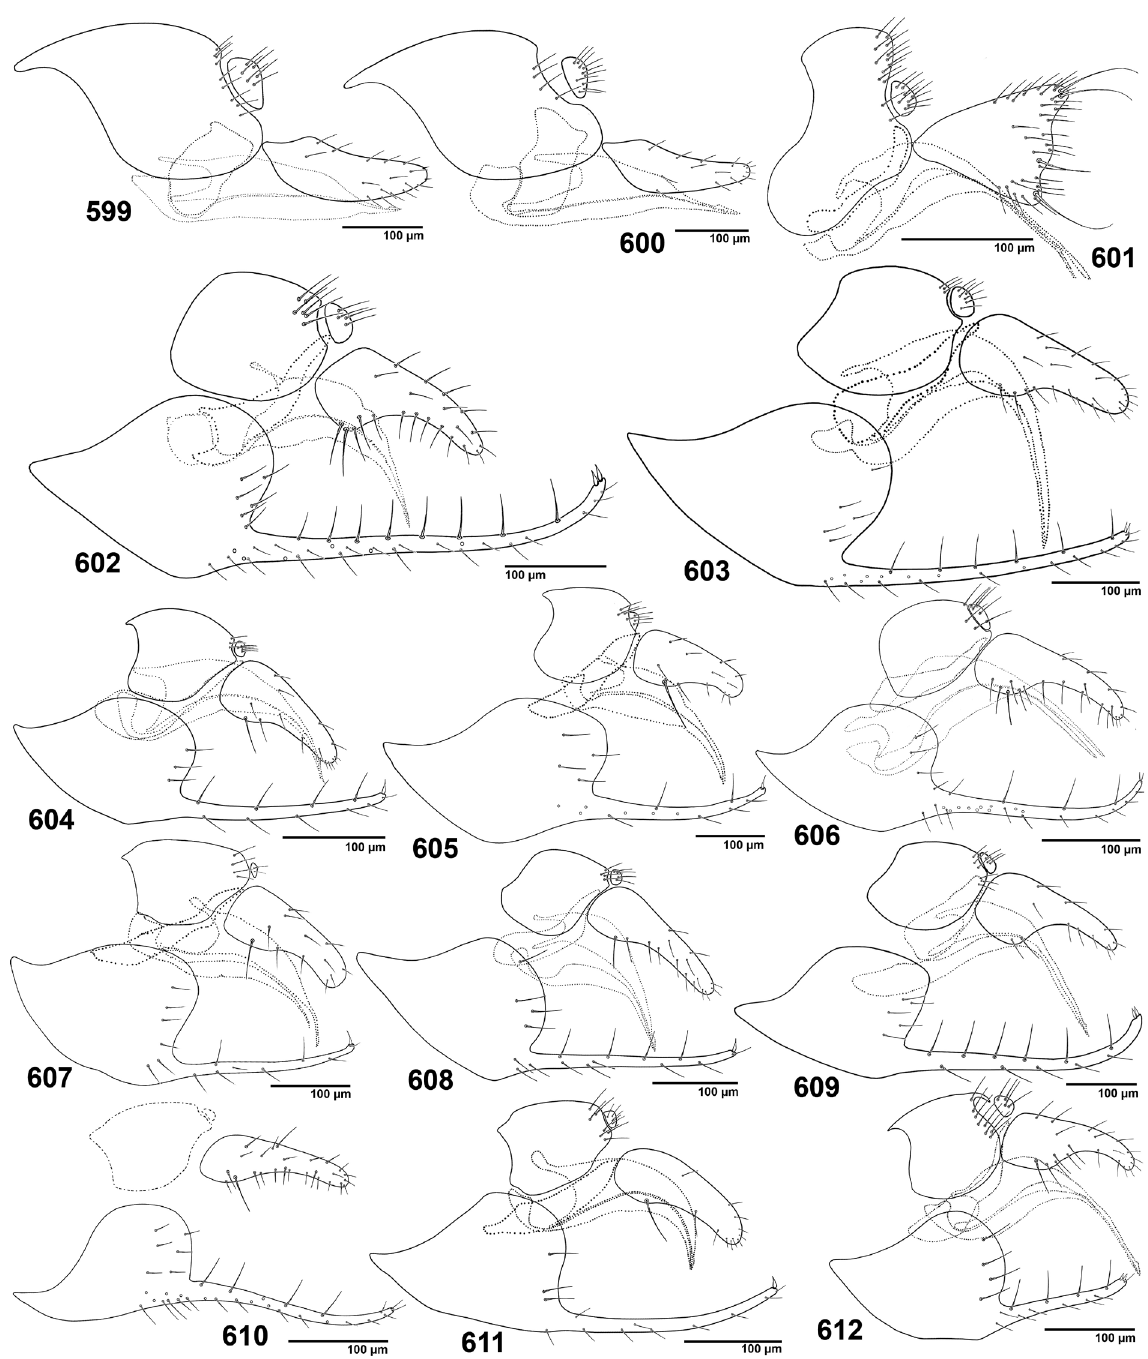
Figs 599–612. Lateral aspect of ♀ genitalia: 599 . Praon volucre . 600 . Praon yomenae . 601 . Toxares deltiger . 602 . Trioxys asiaticus . 603 . Trioxys cirsii . 604 . Trioxys complanatus . 605 . Trioxys curvicaudus . 606 . Trioxys metacarpalis . 607 . Trioxys moshei . 608 . Trioxys pallidus . 609 . Trioxys pannonicus . 610 . Trioxys pappi . 611 . Trioxys quercicola . 612 . Trioxys tanaceticola